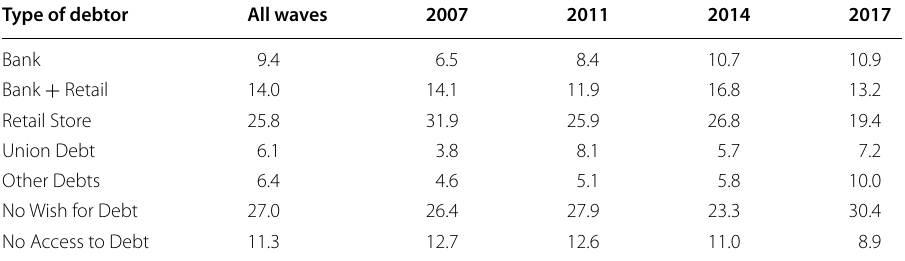
Table 1 Fraction of households (in %) choosing each type of debt over the years Type of